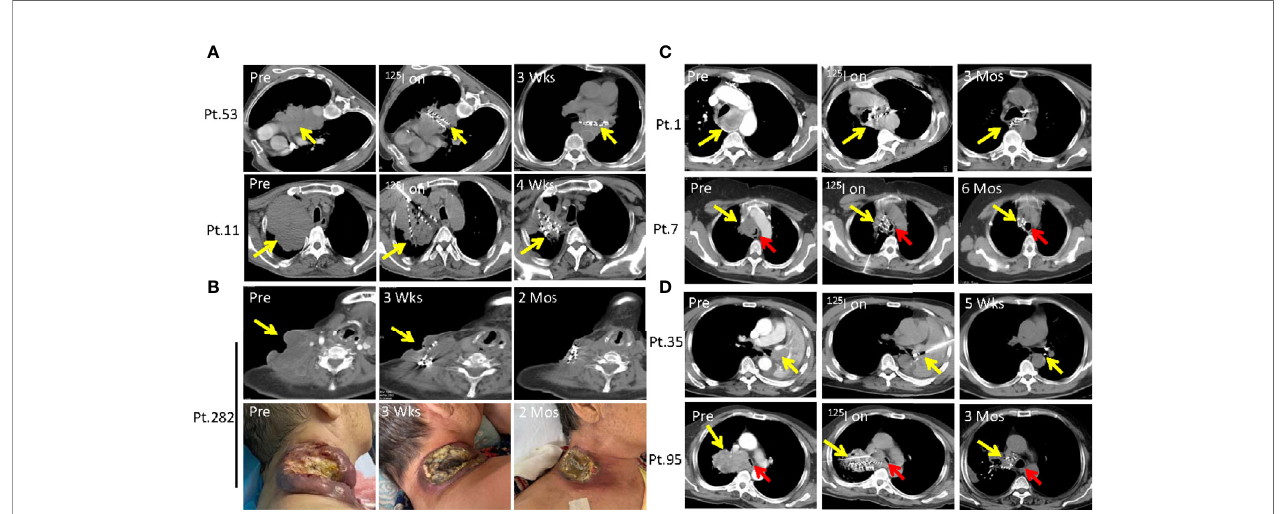
FIGURE 3 | SNCP- 125 I brachytherapy induces rapid regression of large solid tumor that recurred after conventional treatment. (A) Patient 53 was diagnosed with large advanced mediastinal lung squamous cell carcinoma that constricted the heart and the esophagus and caused arrhythmia and dysphagia. Patient 11 progressed on chemotherapy and radiotherapy, developed a large lung squamous cell carcinoma in the left lung with no druggable targets as detected by DNA sequencing, and eventually showed a poor performance status. Tumors of Patient 11 and 53 rapidly regressed 3 and 4 weeks after SNCP- 125 I brachytherapy, respectively . (B) Patient 282 was diagnosed as esophageal cancer with a large metastatic and rupturing tumor in the neck. Following SNCP- 125 I brachytherapy, the tumor regressed in 3 weeks. (C, D). Patients 1, 7, 35 and 95 with progressive lung squamous cell carcinoma all experienced acute dyspnea because of airway obstruction. Tumors signi fi cantly regressed and the main airway was completely reconstructed in 5 weeks to 6 months. Yellow arrow-tumor, Red arrow-airway.